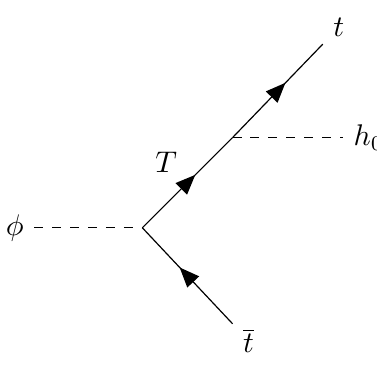
Figure 9. Feynman diagram for Yukon decay φ → tth 0